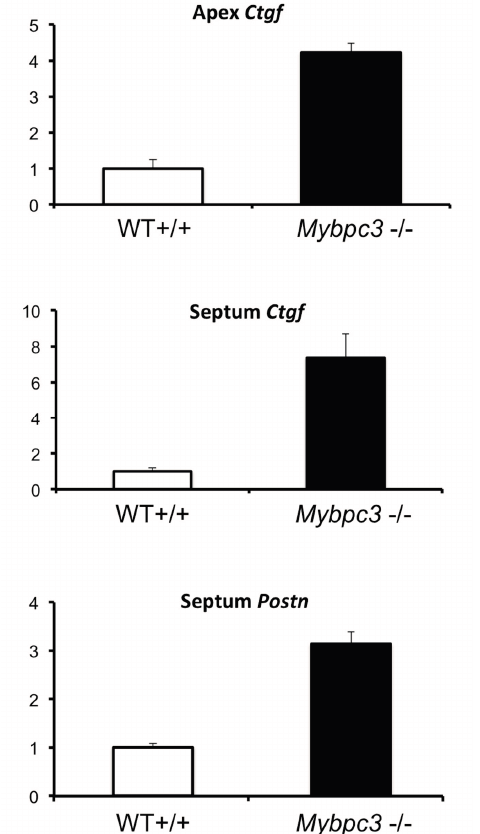
Figure 5 . Increased expression of Ctgf and Postn in Mybpc3 ( − / − ) hearts. The relative mRNA expression of Ctgf , encoding connective tissue growth factor, and Postn , encoding periostin, is shown with the wild-type (+/+) level set at 1.0. Bar graphs show the average relative gene quantification (N = 3 for each genotype and each tissue) with